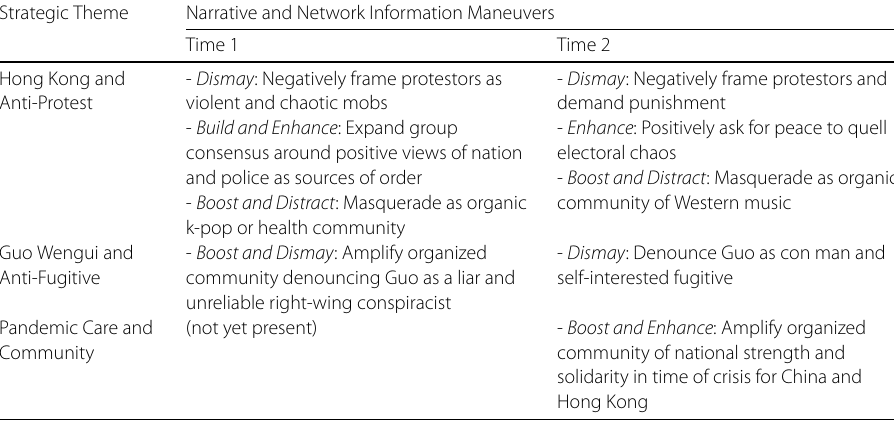
- Dismay : Negatively frame protestors and demand punishment - Enhance : Positively ask for peace to quell electoral chaos - BoostandDistract : Masquerade as organic community of Western music - Dismay : Denounce Guo as con man and self-interested fugitive